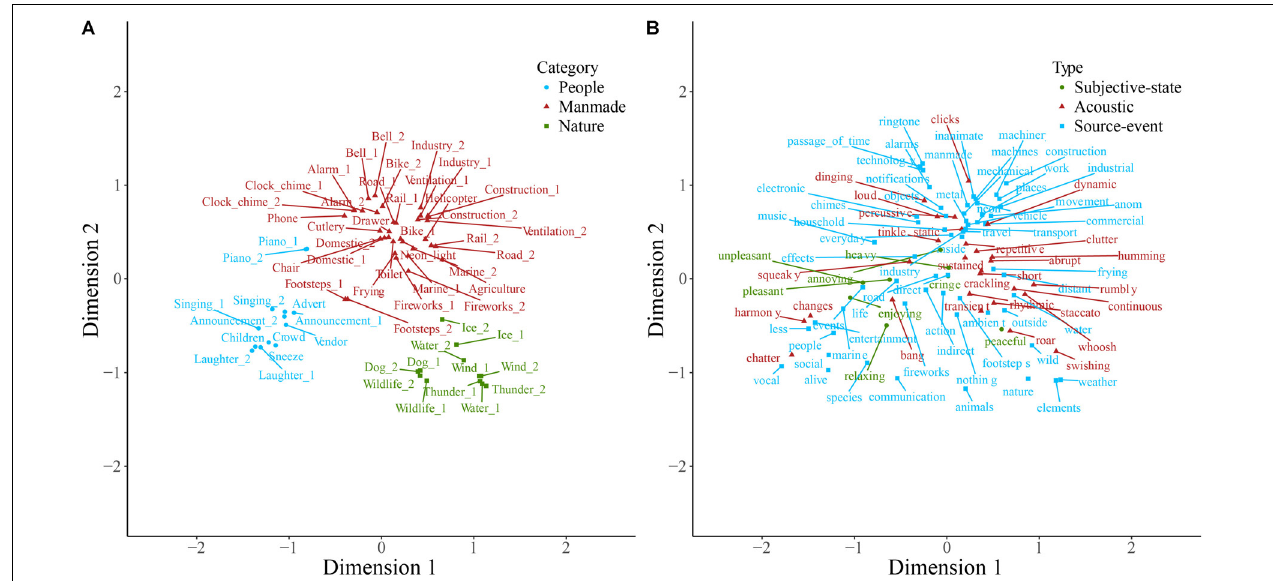
FIGURE 1 | Soundscape sounds (A) and descriptive words (B) plotted on the first two dimensions of categorization data. Note that the dimensions are the same in both panels. Sounds (A) are colored according to which of the main categories they belong to, and descriptive words (B) are colored according to type. Labels are displaced from their corresponding data point, indicated by a connecting line, to avoid